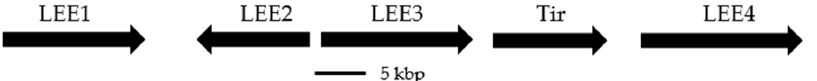
Figure 2. Gene map for the locus of enterocyte effacement (LEE) in E. coli , indicating the five major promoter regions [40].